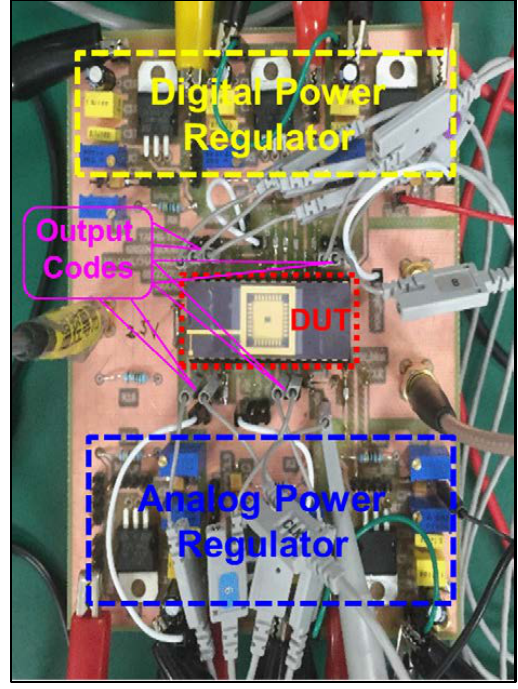
Figure 15. Measured DUT PCB of the proposed SAR ADC .